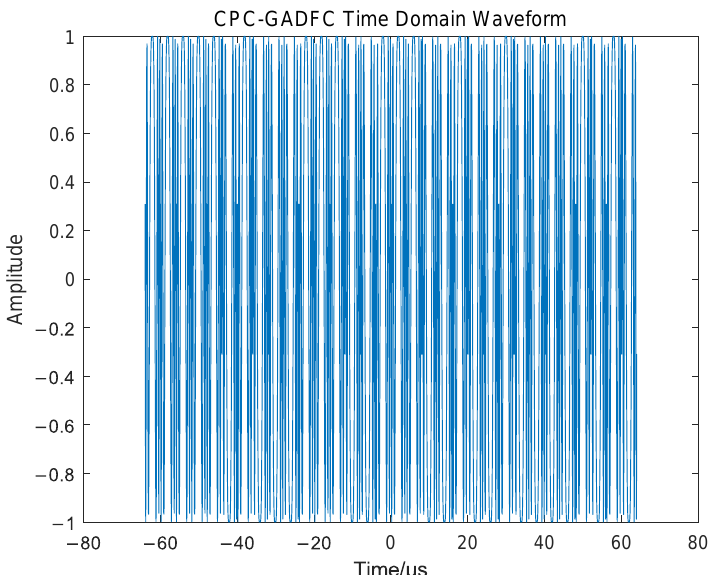
Figure 10. CPC -GADFC Time Domain Waveform.